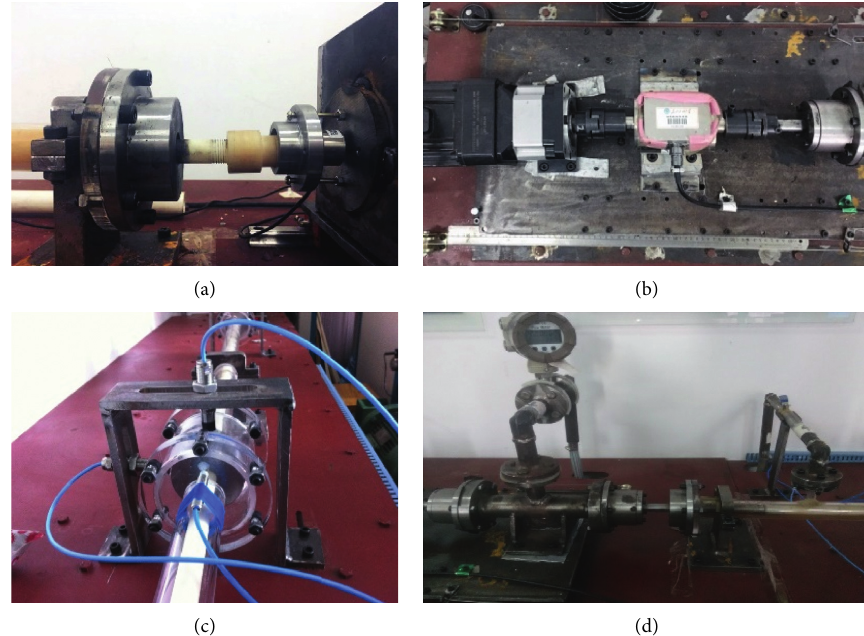
Figure 11: Composite of the experimental apparatus: (a) loading system; (b) driving system; (c) testing system; (d) circulatory system.